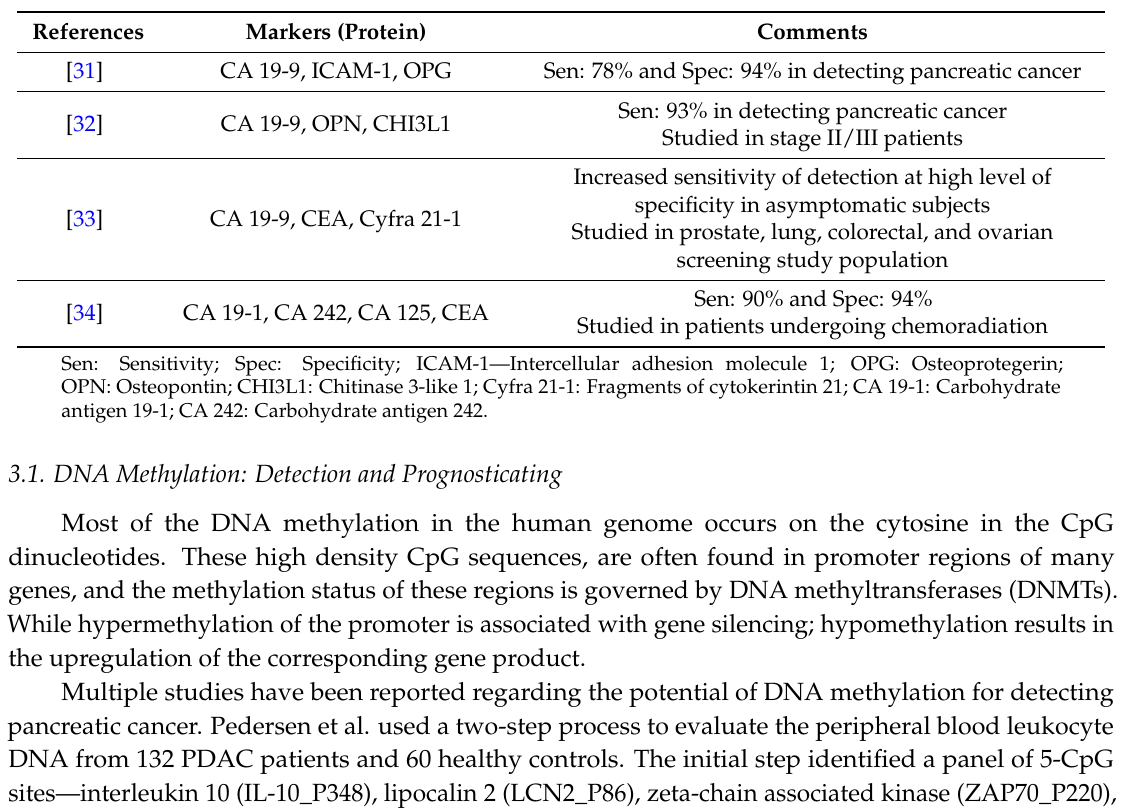
Table 4. Summary of multimarker